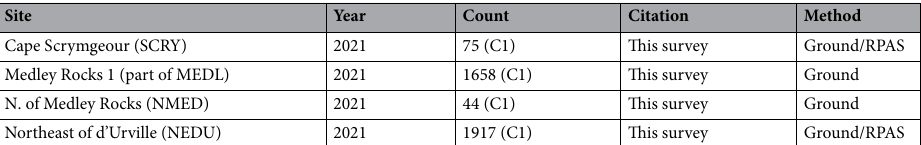
Table 2. Gentoo penguin colony survey history. Available gentoo penguin census data for colony locations surveyed during this expedition. Additional data from previous surveys have been included so as to place new data in its historical context; these data may also be downloaded from the Mapping Application for Penguin Populations and Projected Dynamics 7 (MAPPPD; www. pengu inmap. com). Each sites 4 letter MAPPPD code has been included. The methods of survey are: Ground, Survey was conducted by researchers on the ground; RPAS, Remotely-piloted aircraft systems; vhr, very-high resolution commercial satellite imagery; vessel, survey conducted by an offshore vessel.